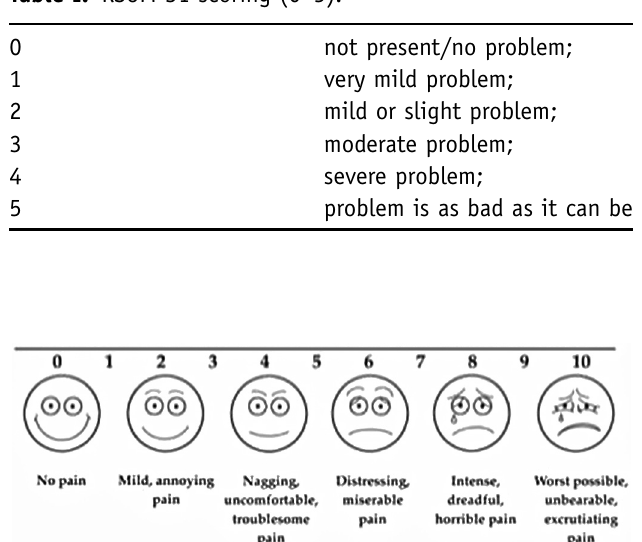
Table I. RSOM-31 scoring (0 – 5).